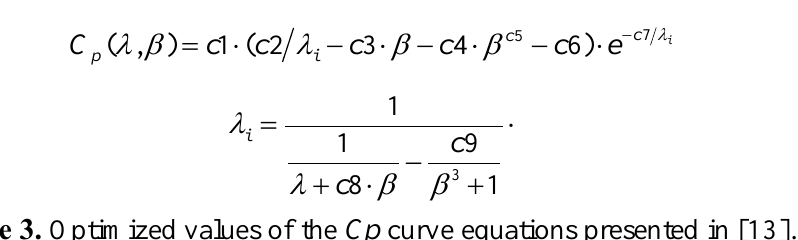
Table 3. Optimized values of the Cp curve equations presented in [13].